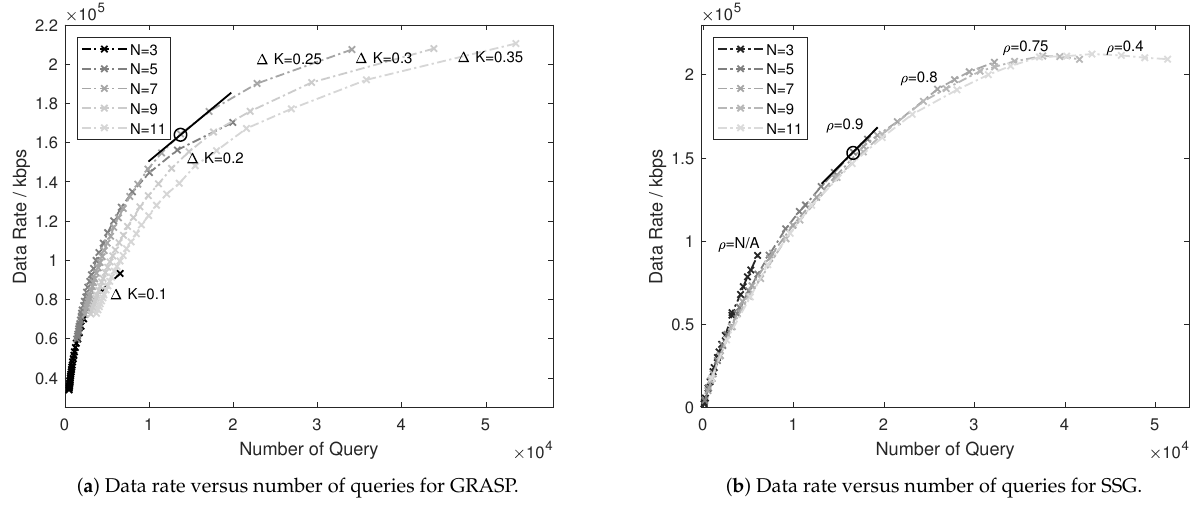
( b ) Data rate versus number of queries for SSG. Figure 4. Trade-off balancing for GRASP and SSG, M =